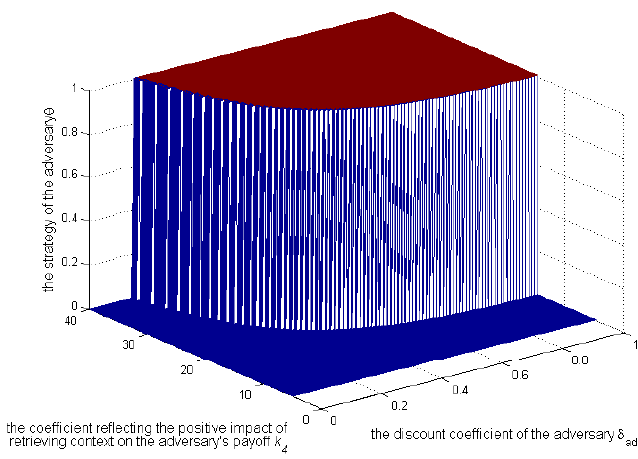
Figure 10. Impact of k 4 and δ ad on the adversary’s